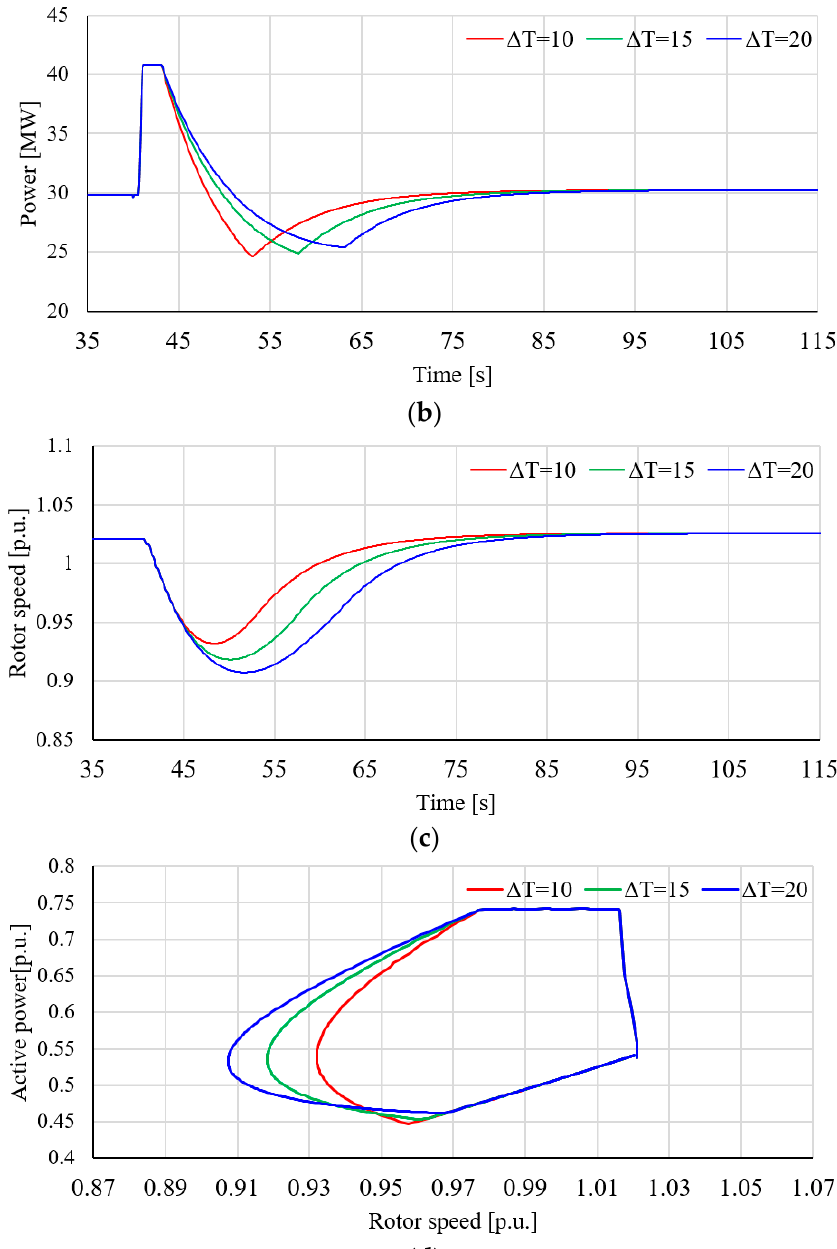
Figure 8. Results for Case 1. ( a ) System frequency; ( b ) Output power of the wind farm; ( c ) Rotor speed; ( d ) Output power in the rotor speed domain.